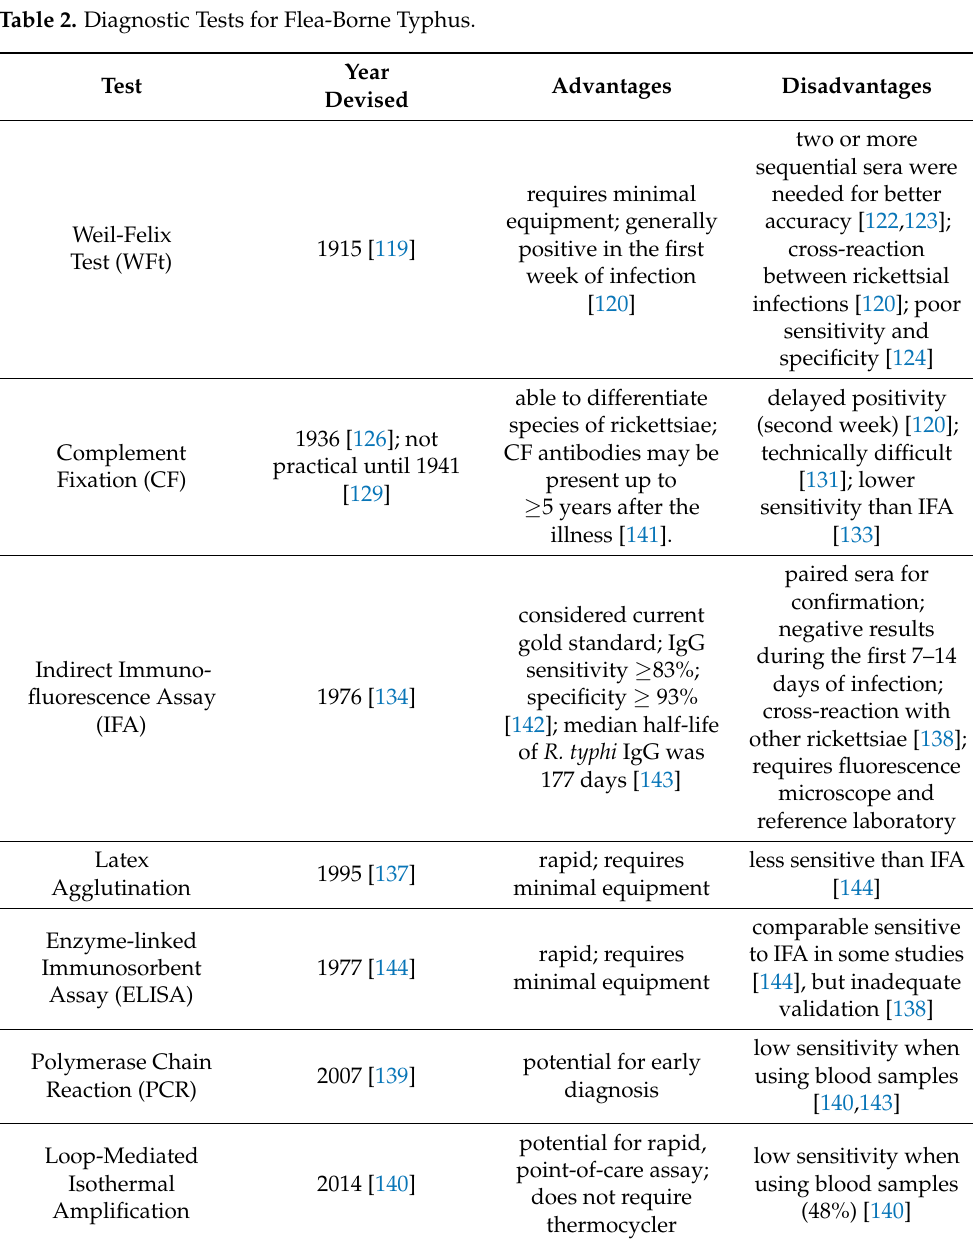
Table 2. Diagnostic Tests for Flea-Borne